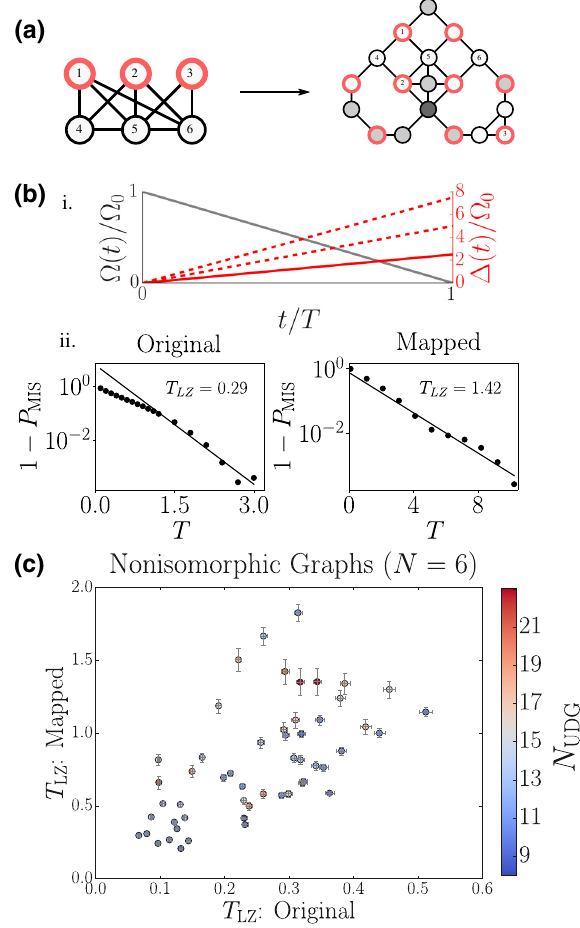
FIG. 9. QAA performance for MWIS on original and mapped graphs. (a) Example unit-disk mapping and MIS configuration of a six-vertex graph. The original graph (left) is unweighted, and the mapped graph is a weighted UDG (right). The correspond- ing vertices are labeled with numbers. (b) i. Rabi frequency (cid:2)( t ) and detuning (cid:3)( t ) sweep used in the QAA protocol. The global detuning (cid:3)( t ) is shown in solid red, while 2 (cid:3)( t ) and 3 (cid:3)( t ) are shown in dashed lines. ii. Computed P MIS for the original and mapped graphs as a function of total sweep time T . The adia- batic timescale T LZ , which is related to the minimum energy gap, is extracted from the long-time Landau-Zener fitting. (c) Scal- ing of T LZ for mapped graphs for the ensemble of unweighted nonisomorphic graphs with size N =